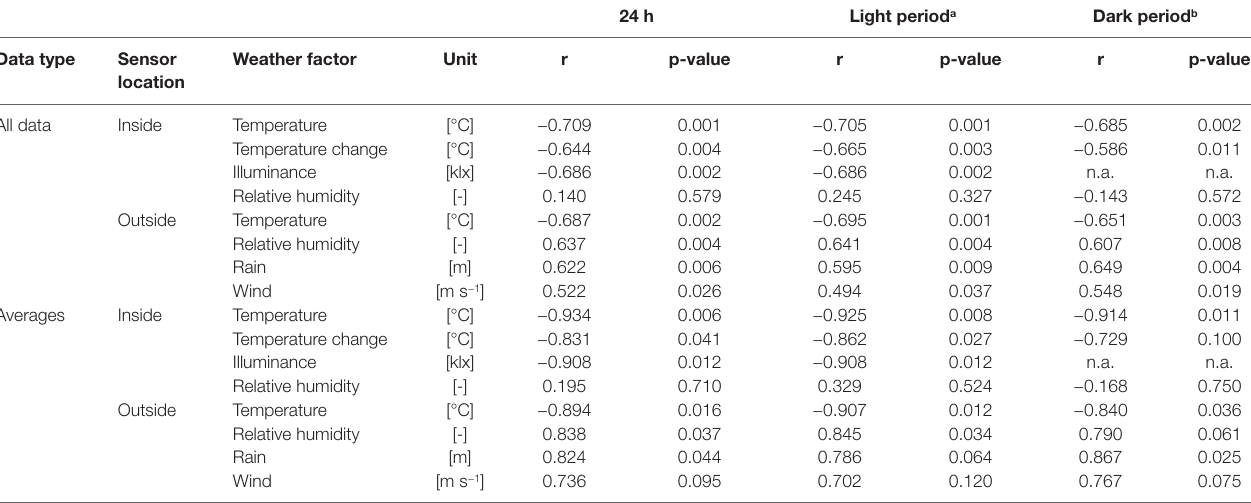
TABLE 1 | Correlation between climate factors during plant growth and DFE